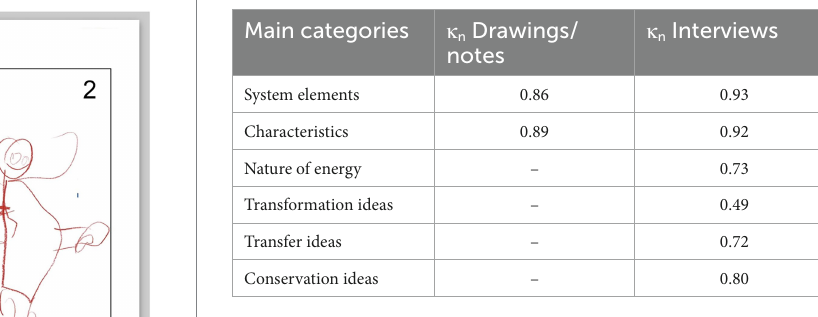
FIGURE 1 Energy drawing of a first grader (Is) with two coding units (1: flashlight, 2: human beings).